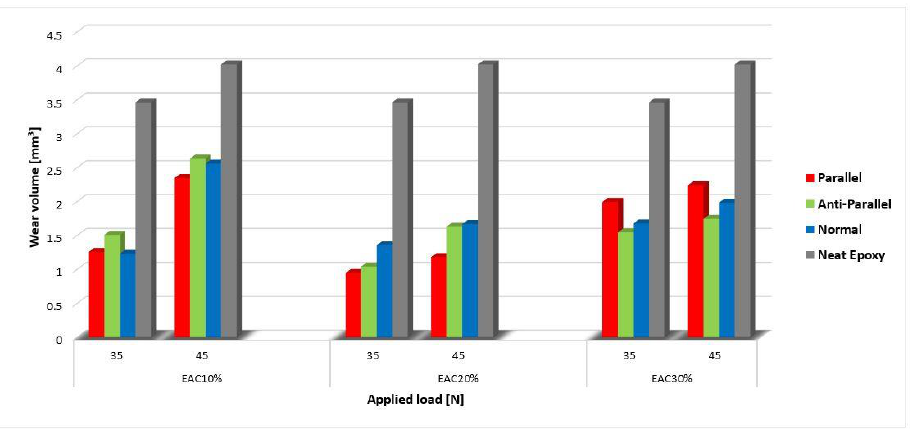
Figure 7. Wear volume of the EAC’s and NE for different percentages of abaca fiber and applied load, after 800 m of sliding distance.